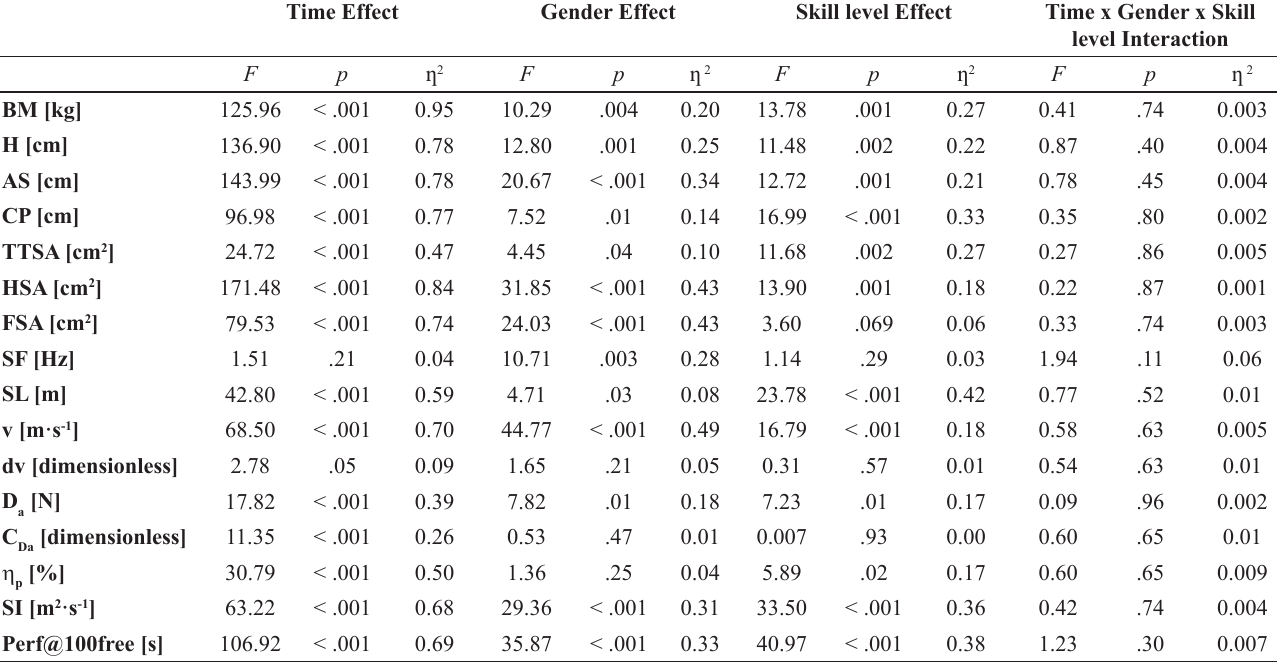
Table 1. Data variation (ANOVA 3-way) during the two competitive seasons for total group of